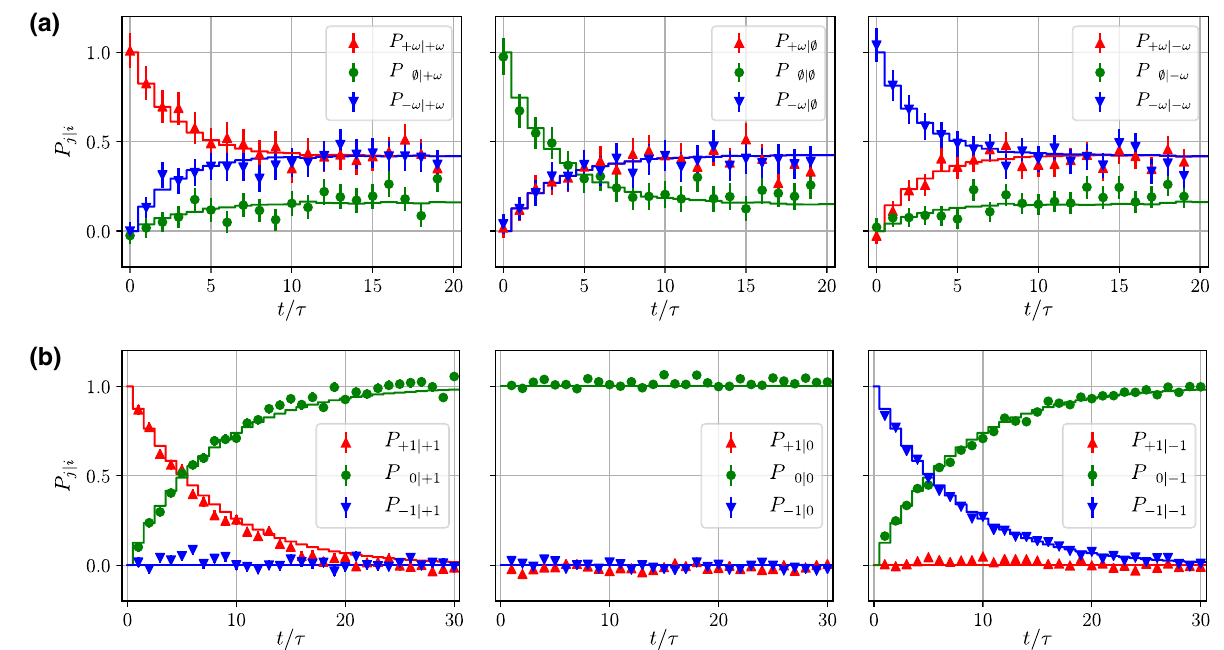
FIG. 2. Dynamics of the spin qutrit under the autonomous dissipative Maxwell’s demon. The probability P j | i of measuring the state (cid:2) after applying the map M to the state | E (cid:2) is shown as a function of the number of laser pulses N | E j i represent each of the eigenstates of the 3LS Hamiltonian (a) H MW and (b) H NV . In both cases, the duration of the laser pulses t L = 41 ns, and the time between pulses τ = 424 ns. Each panel corresponds to a different initial eigenstate: (a) {|+ ω (cid:2) , |∅(cid:2) , |− ω (cid:2)} and (b) {|+ 1 (cid:2) , | 0 (cid:2) , |− 1 (cid:2)} . The markers with error bars represent the experimental data, and each solid line corresponds to the calculation performed with the theoretical model of the map M , as described in Sec. III. Experimental error bars are mainly due to photon shot noise. Notice that these measurement stem from a comparison between the PL of the two reference states and the PL of the NV center after the studied dynamics, which may result in values that are slightly outside the interval [0,